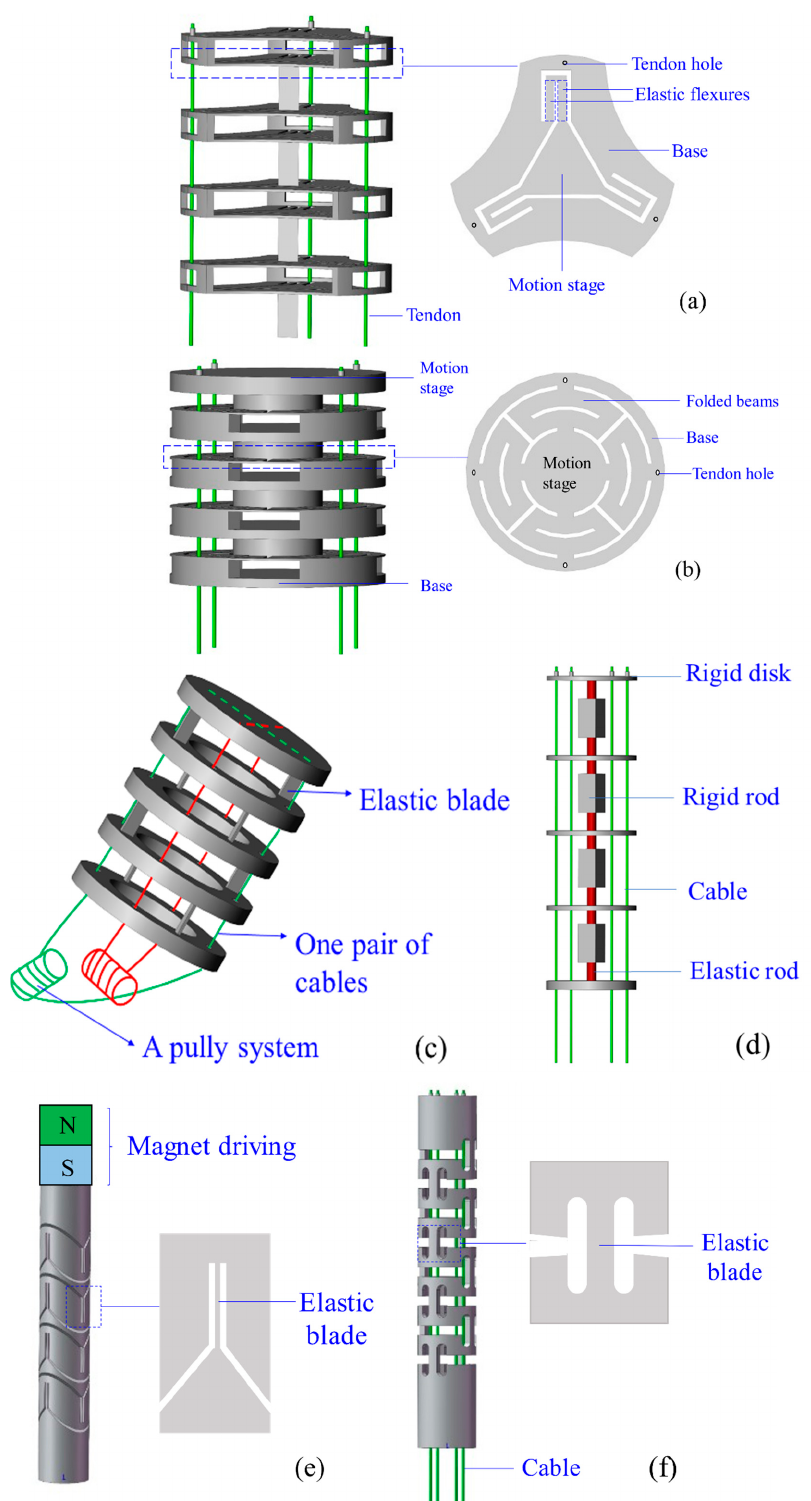
Figure 8. Different compliant joints for the compliant-joint CCRs: ( a ) A planar spring [92], ( b ) a planar spring with minimised parasitic motions [93], ( c ) multi-two-pivots compliant joints [20], ( d ) a compliant joint with two short elastic beams [94], ( e ) multi compliant joints with elastic blades [95] and ( f ) multi compliant joints with round-corner blades [96].